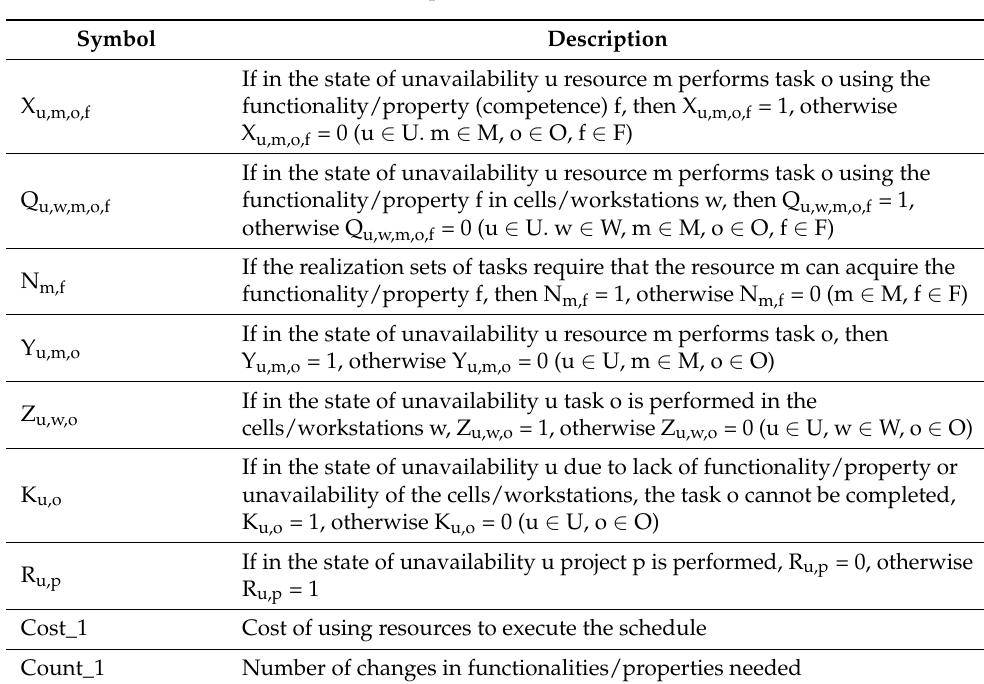
Table 2. Model decision variables and computed